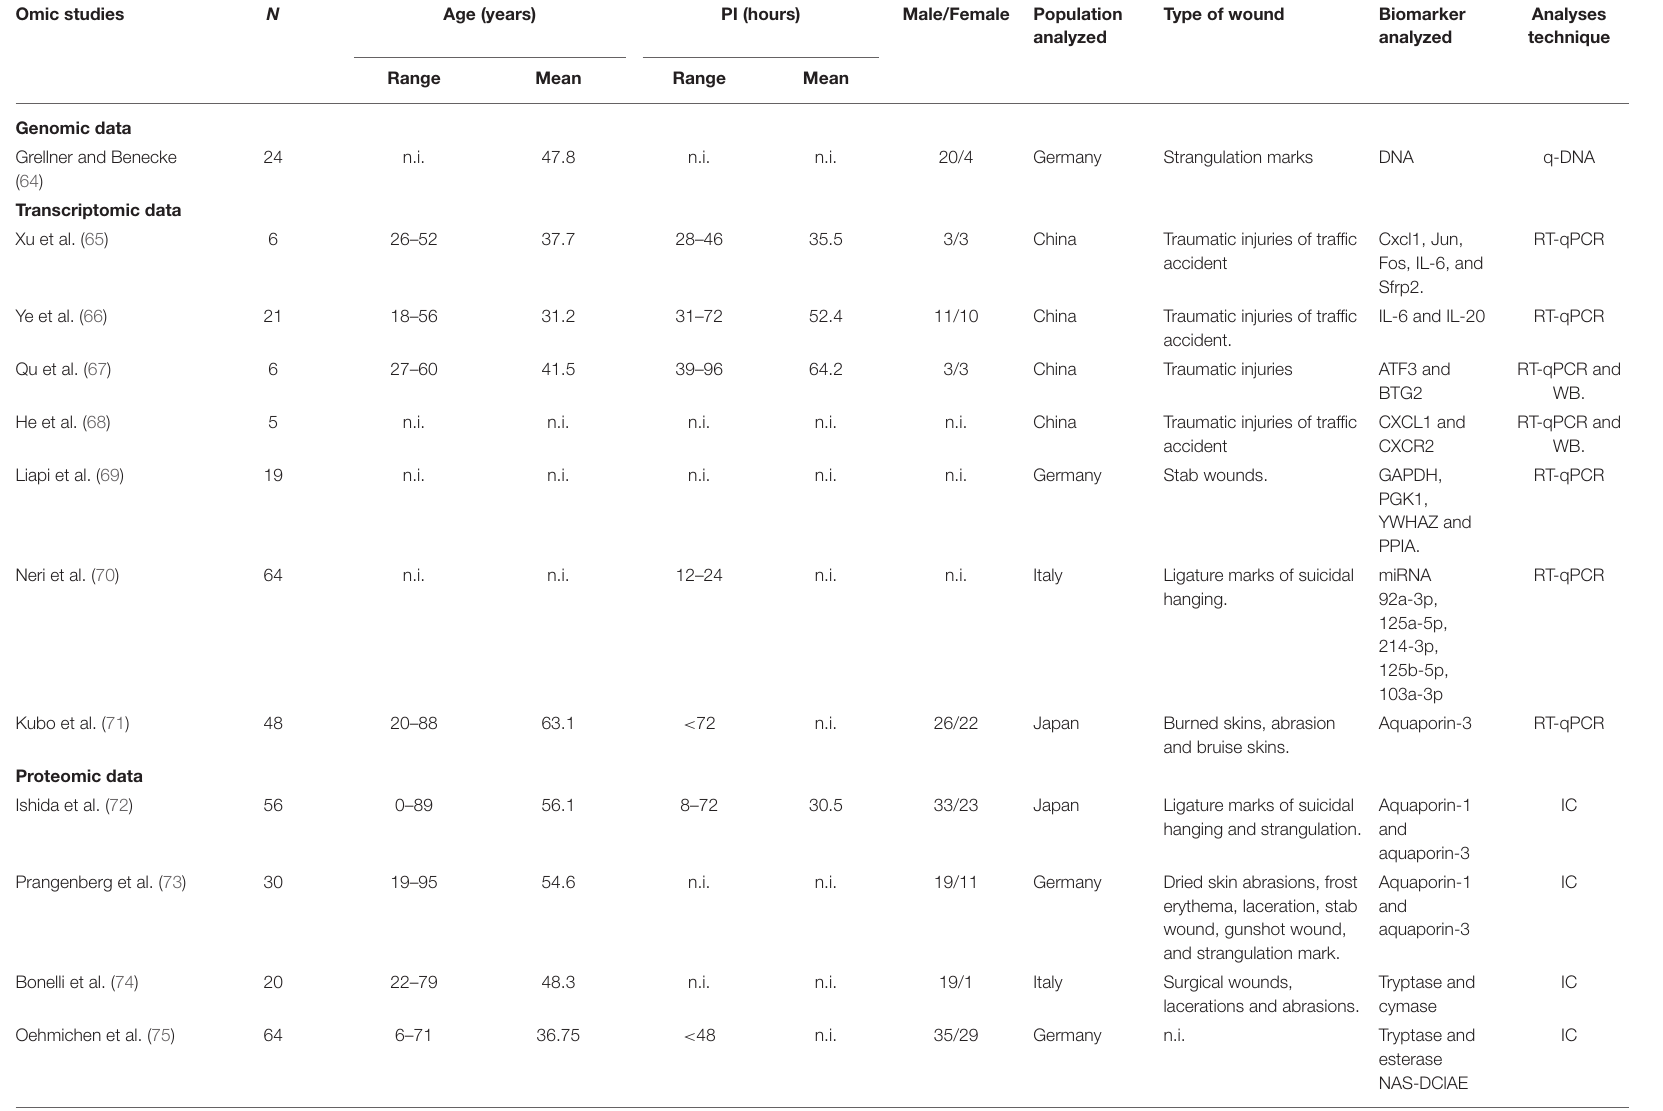
TABLE 4 | Differentiation of vital and post-mortem wound in post-mortem studies a